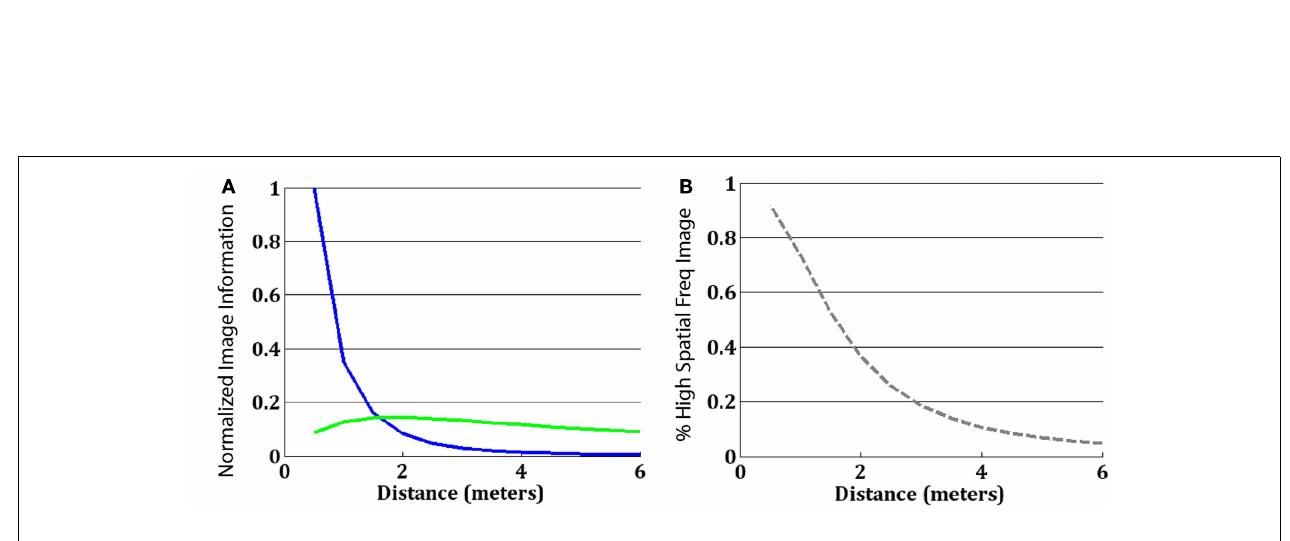
1.0. (B) The percentage of all information about the image available at a given distance that comes from the high spatial frequency